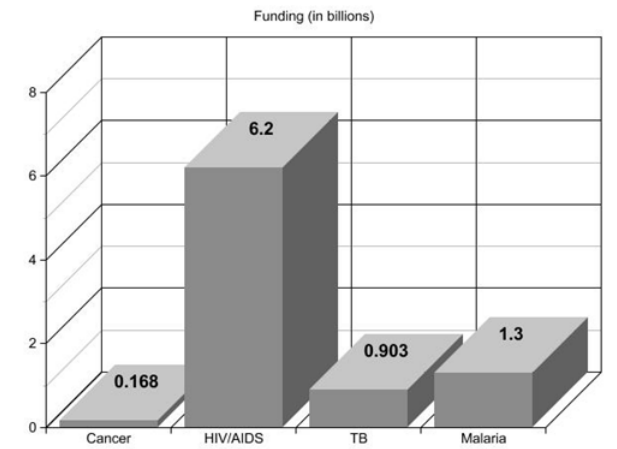
Figure 3. Funding (in US$) allocated to combat cancer, HIV/ AIDS, tuberculosis (TB), and malaria in the developing world. Funding for prevention and treatment of cancer amounts to approximately 2% of what is put towards other diseases